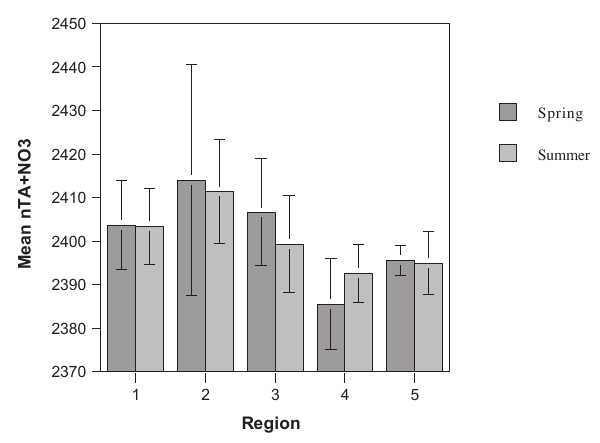
Figure 11 . Spring to summer changes in observed surface nTA+NO 3 ( µ moles kg -1 ) for the following regions of the Bering Sea shelf: (1) the North Line; (2) the Middle Line; (3) between Nunavak Island and Pribilof Islands, (4) south of the Probilof Islands, and; (5) SE Bering Sea shelf.